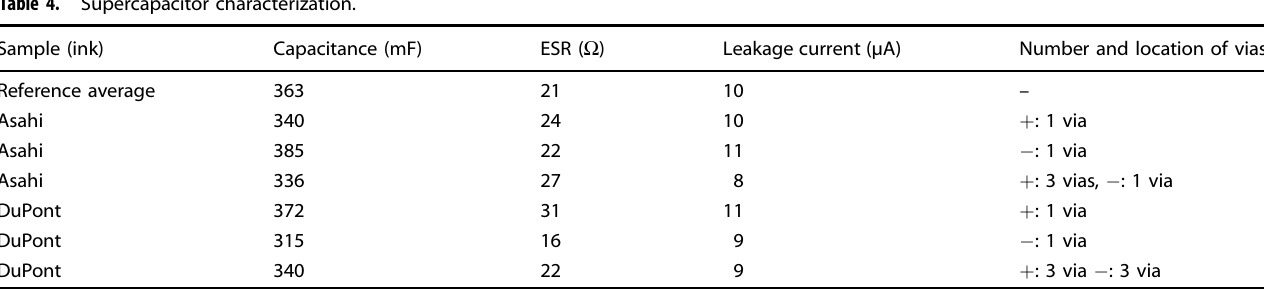
Table 4. Supercapacitor